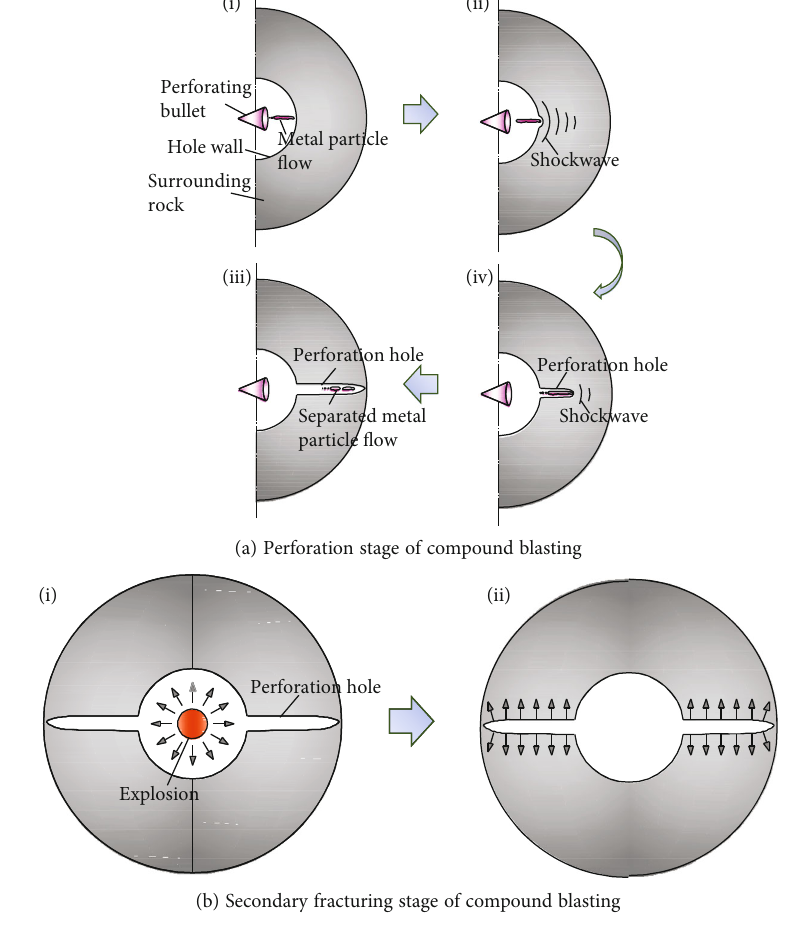
Figure 2: The process of compound blasting.